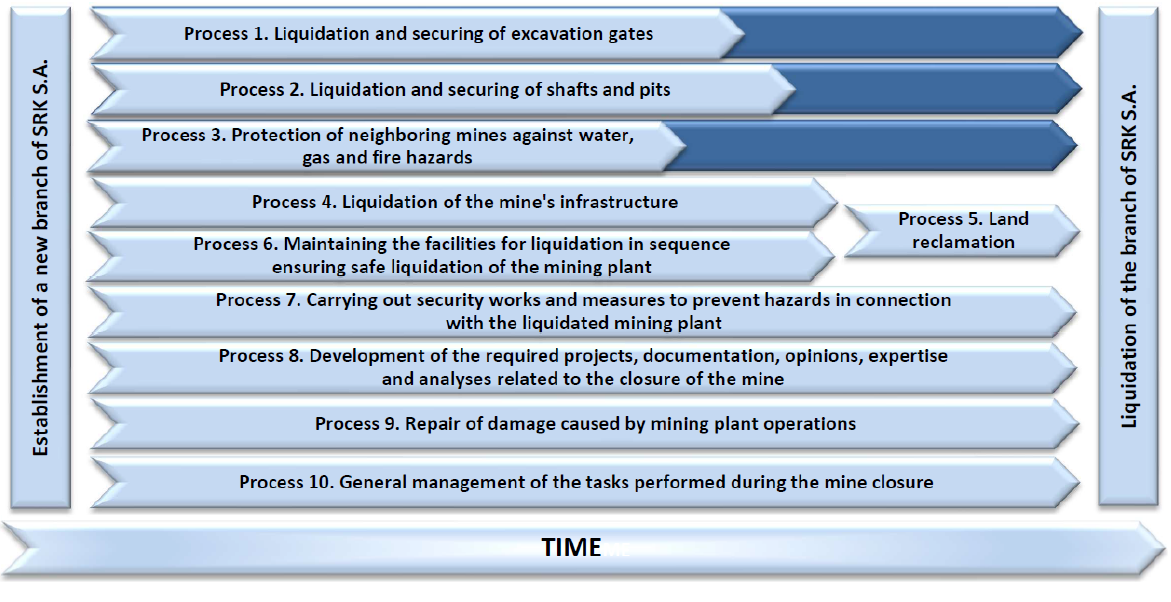
Figure 1. Mine liquidation processes in SRK S.A. Source: Data from SRK S.A.